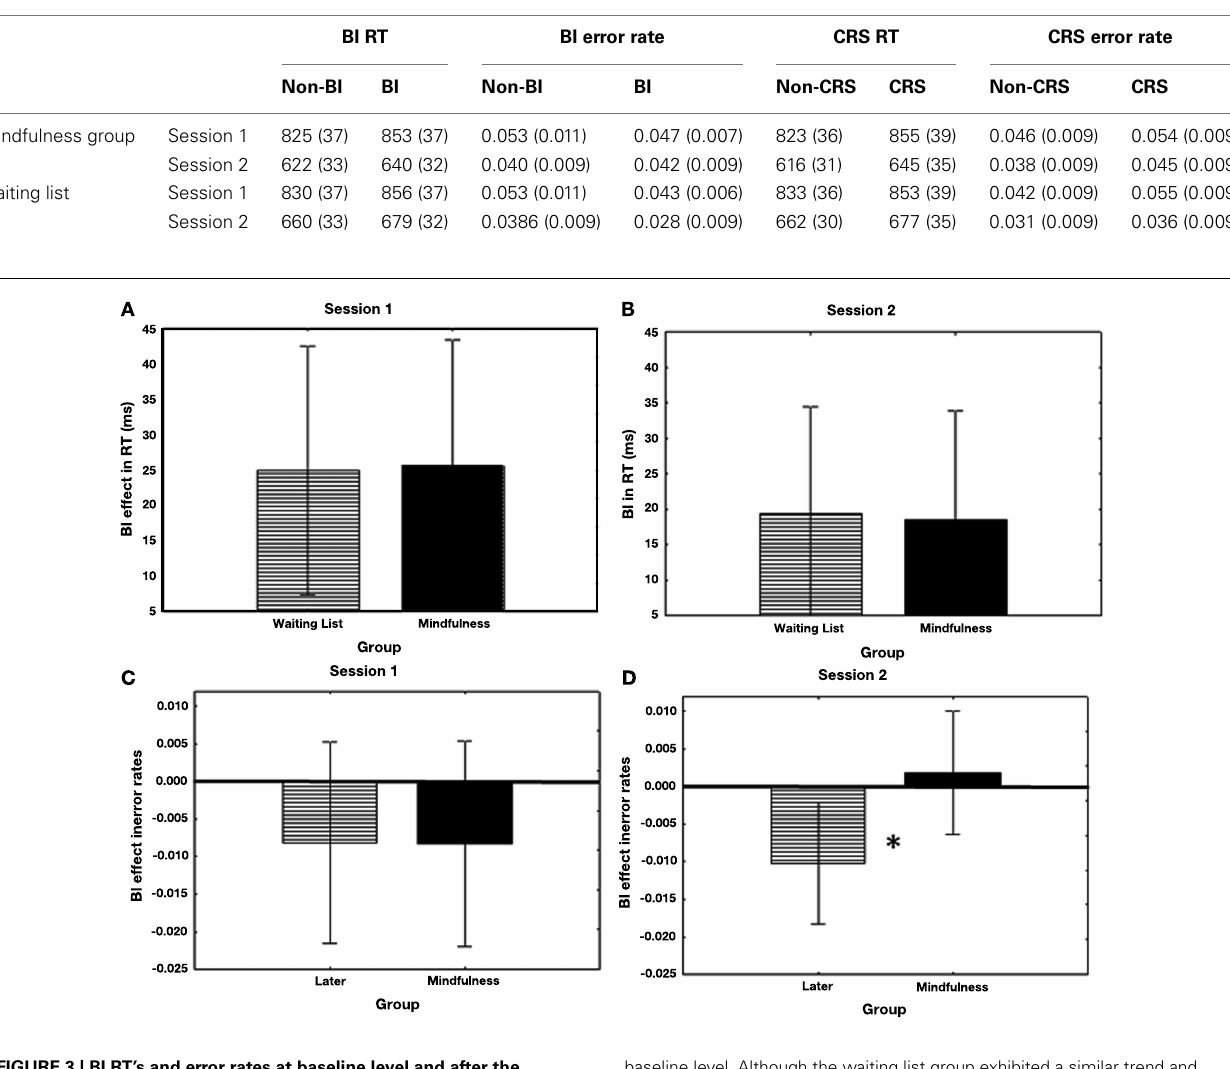
Table 1 | BI and CRS means and SD’s (in parenthesis) at baseline level and after the mindfulness program.